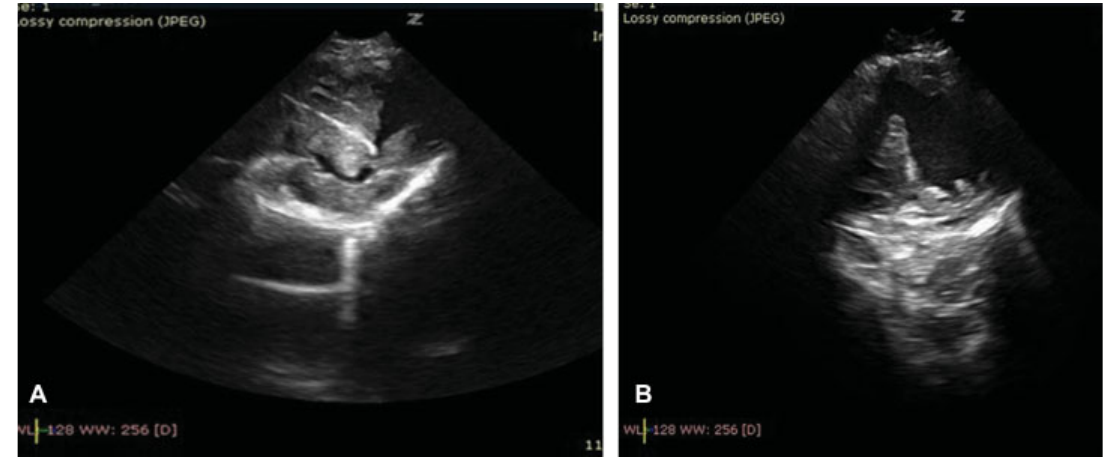
Fig. 3 ( A ) Intracardial metal strut ending its course in the left ventricle “ muffed ” by thrombus; ( B ) iatrogenic ventricular septal defect after strut and thrombus